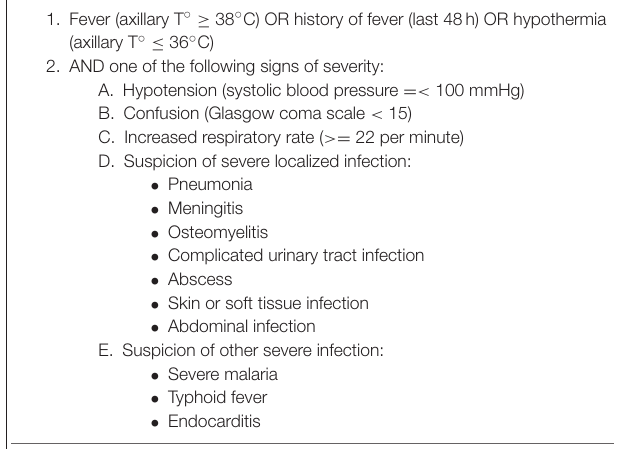
FIGURE 3 | Proposal for clinical indications of bloodstream infections in LMICs (3,